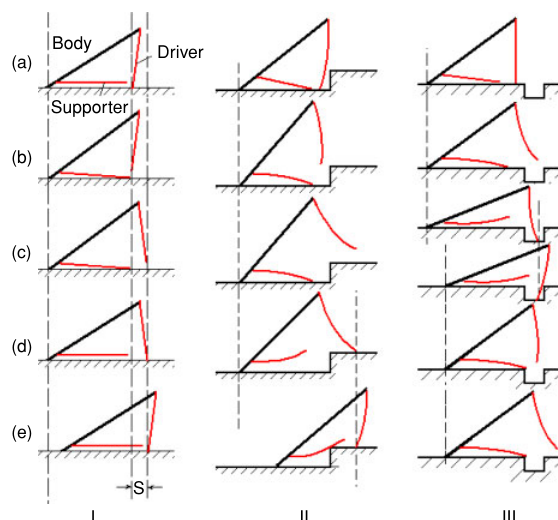
Figure 6 Different strategies for different environments.